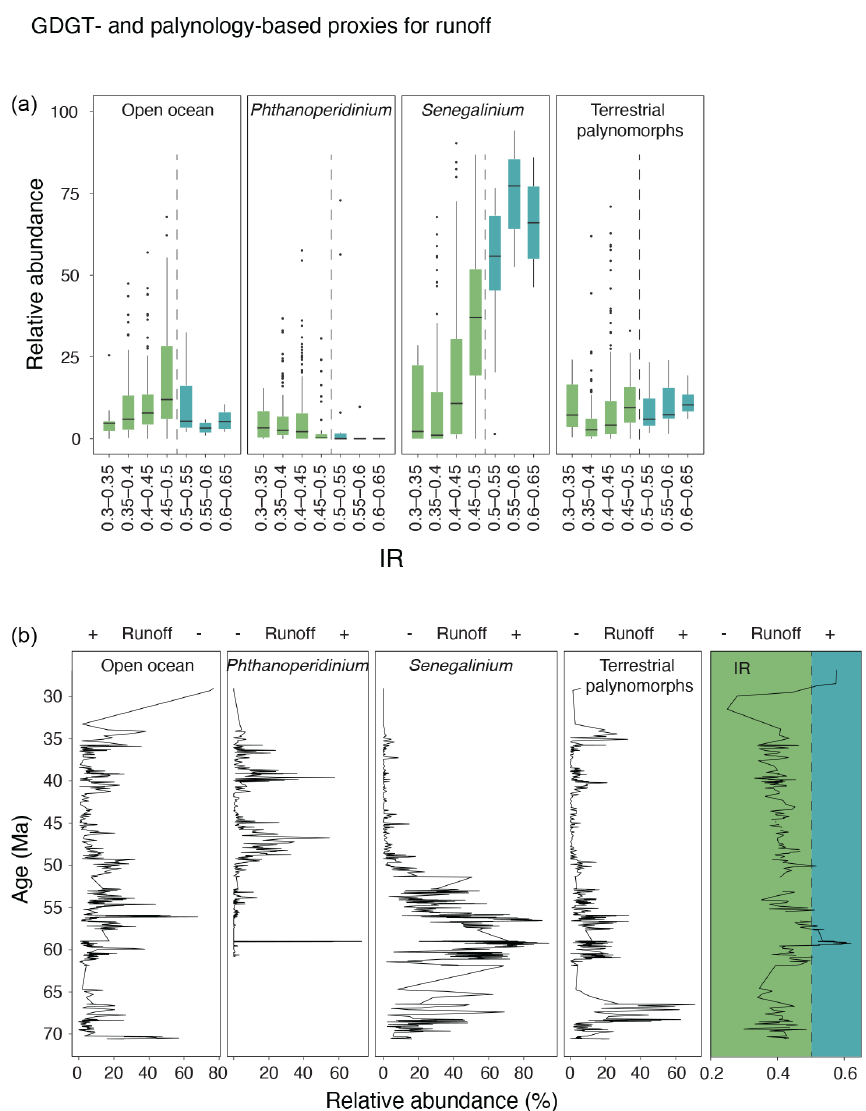
Figure 16. BrGDGT- and palynology-based proxies for river runoff. (a) Relative abundance of open-ocean, Phthanoperidinium spp., Sene- galinium cpx. (for groups, see Table 3) and terrestrial palynomorphs in 0.05 index unit bins of the resampled IR. The dashed line separates elevated IR bins from non-elevated IR bins. Median (black bars), lower-to-upper quartiles (25th–75th percentiles; colored envelopes), lower- to-upper whiskers (95% confidence intervals; black lines), outlier samples (black dots). (b) Time series of the same palynology eco-groups and the